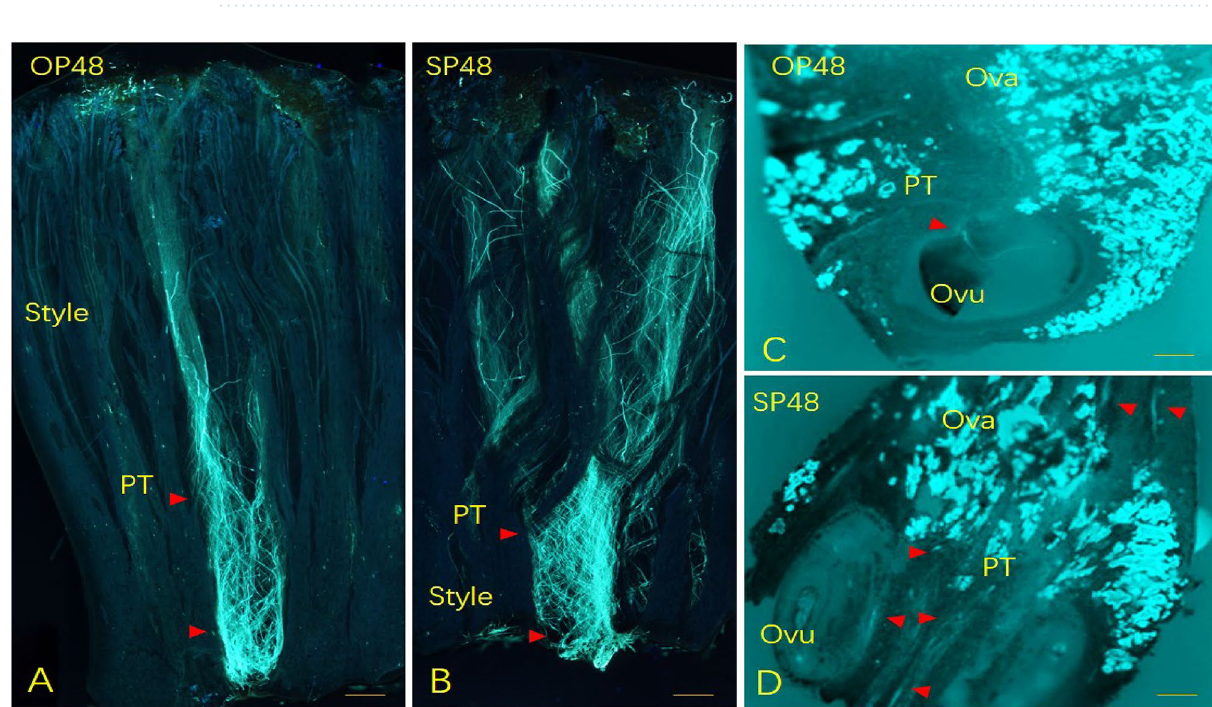
Figure 1. Photographs of flowers ( A ), 72 h fruits after pollination ( B ), 6-month fruits ( C ), 13-month fruits ( D ), 16-month fruits ( E ), and cracked fruits and seeds ( F , 17 months) of S. superba .